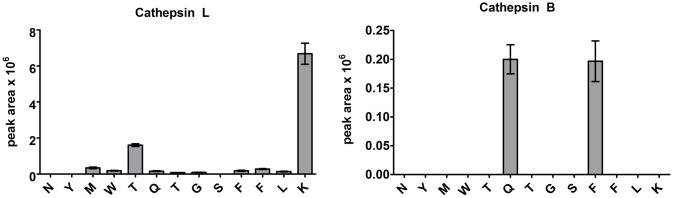
Cathepsin L cleaves ABCA3 peptide preferentially after Lys174.Shown are signal intensities of C-terminal cathepsins L and B cleavage products of ABCA3 peptide (151–194) within the sequence 162NYMWTQTGSFFLK174 analyzed by LC-MS/MS. Extracted MS ion chromatograms of the accurate m/z values ±5 ppm related to the corresponding peptide ions (peak areas) from three experiments were used for the diagram.